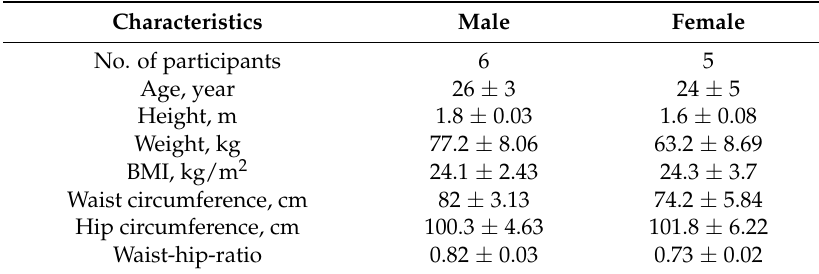
Table 1. Acute study population characteristics in the Intervention